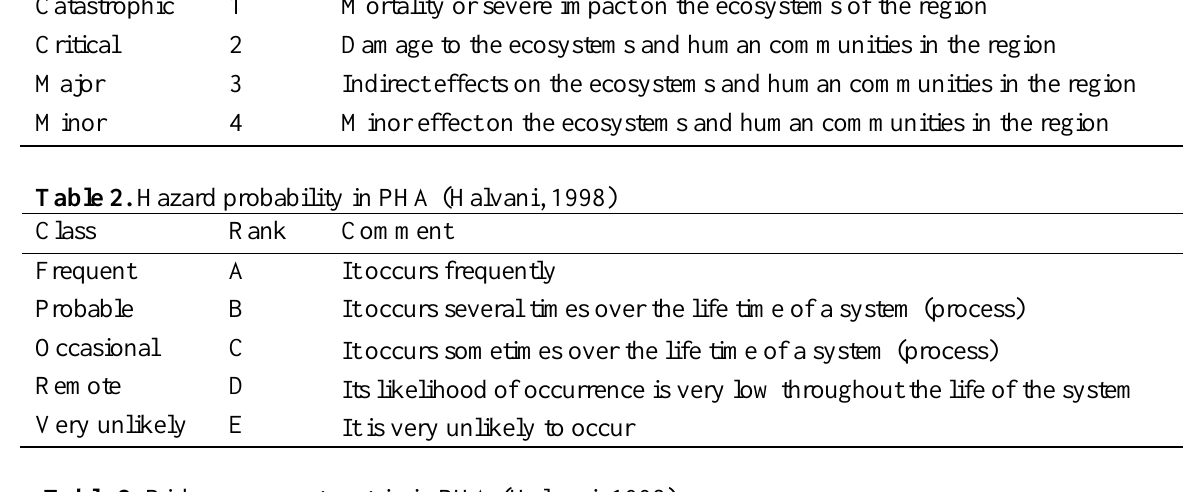
Table 3. Risk assessment matrix in PHA (Halvani, 1998) Impact